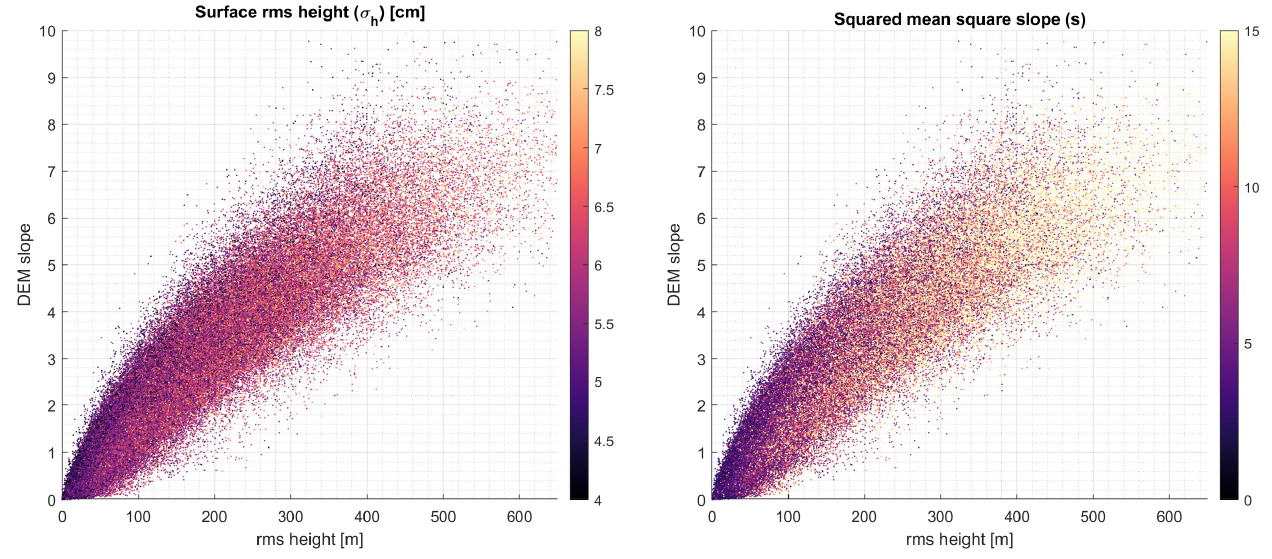
Figure 4. Scatter plot maps between the DEM rms height, DEM slope, retrieved surface rms height (top), and squared mean square slope or slope rms ( s ).